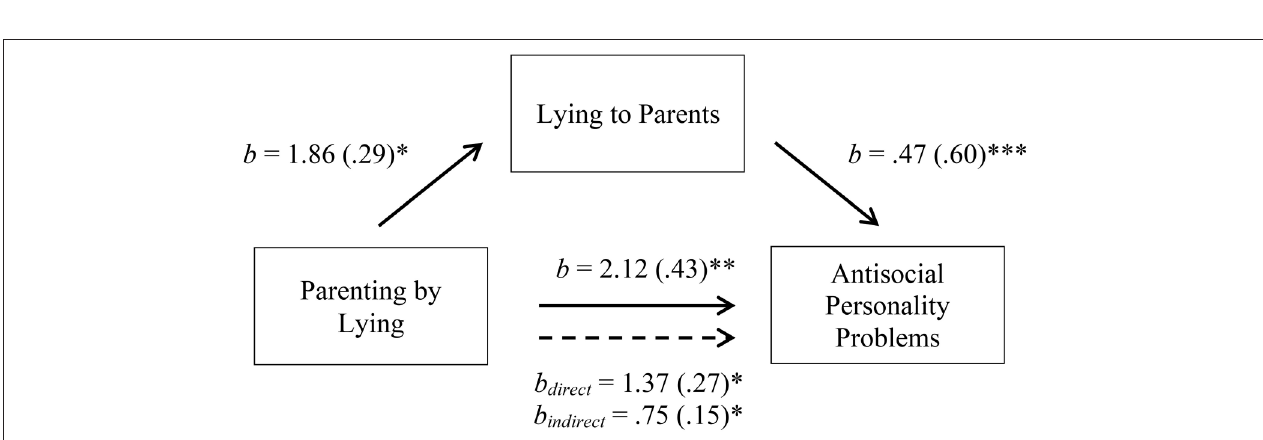
FIGURE 4 | Complementary mediation model between parenting by lying and antisocial personality problems. The solid lines represent the simple linear regressions (paths a, b, and c); the dotted line represents the bootstrapped direct and indirect effects of X on Y after controlling for M. Bracketed values indicate the standardized Beta coefficient. * p < 0.05, ** p < 0.01, *** p < 0.001.